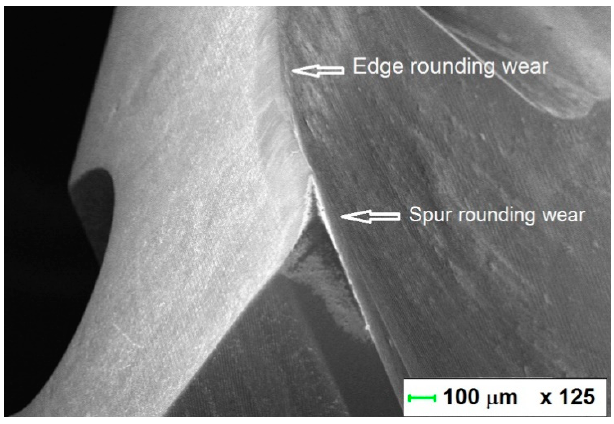
Figure 12. Abrasive wear of the carbide drill in the CFRP showing edge and tip rounding wear.